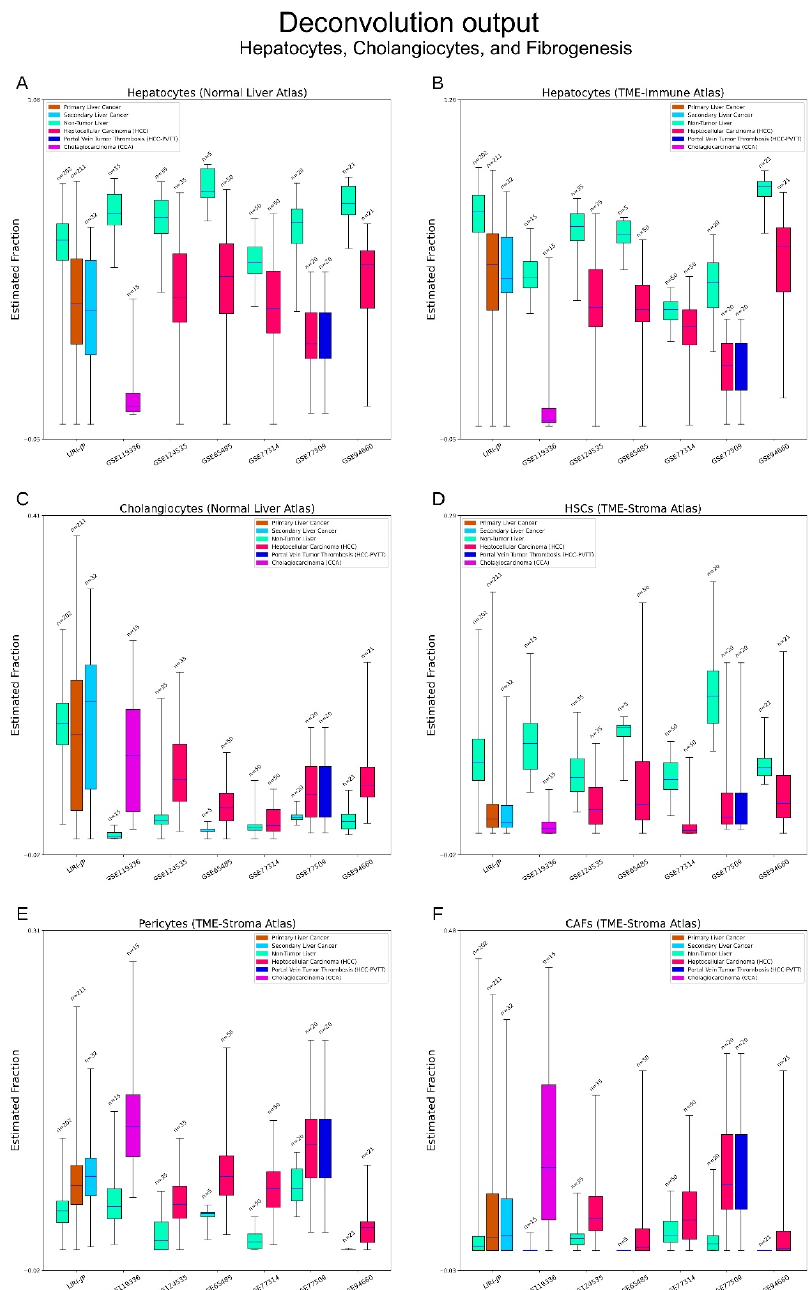
Figure 2. Deconvolution output—hepatocytes, cholangiocytes, and fibrogenesis. ( A , B ) A comparison of hepatocytes estimation by Cibersortx with two different atlases. Subtle differences of cell fractions can be seen between two experiments, but they arrived at the same conclusion, namely that hepatocytes decrease in cancerous tissue. In CCAs, this phenomenon is more prominent. ( C ) Estimation of cholangiocytes. Elevation of cholangiocytes can be widely seen in cancerous tissues. ( D – F ) Estimation of hepatic stellate cells (HSCs), pericytes and cancer-associated fibroblasts (CAFs). These three cell types are key components participating the fibrogenesis of liver cancer. HSCs are liver-specific pericytes, and often activated in liver cancer. Pericytes (broad sense) can be hardly detected in normal liver but are widely present in liver cancer. CAFs are uniquely characterised fibroblasts in cancer. They can hardly be detected in normal liver but are common in cancerous